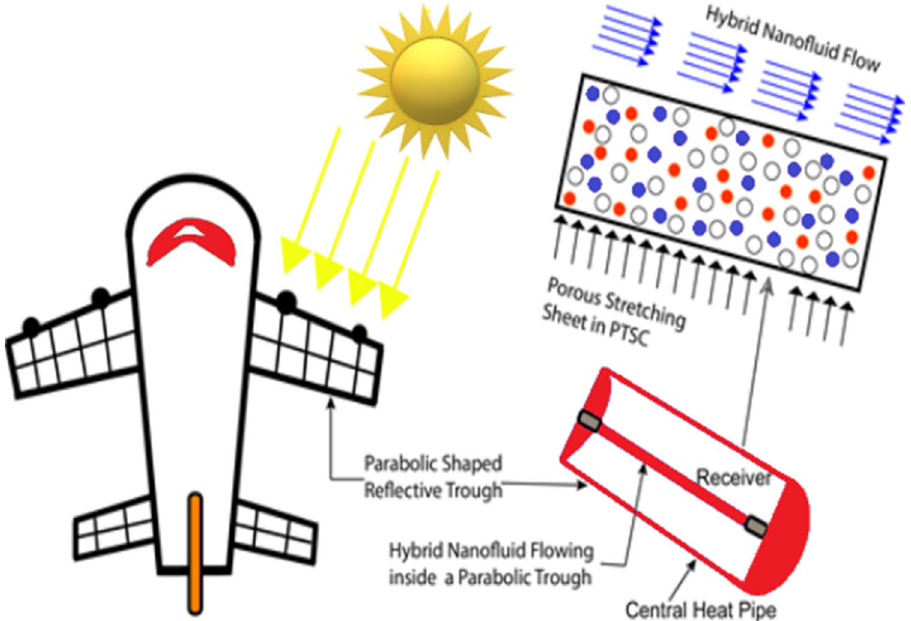
Figure 2. Systematic discription regarding current theoretical